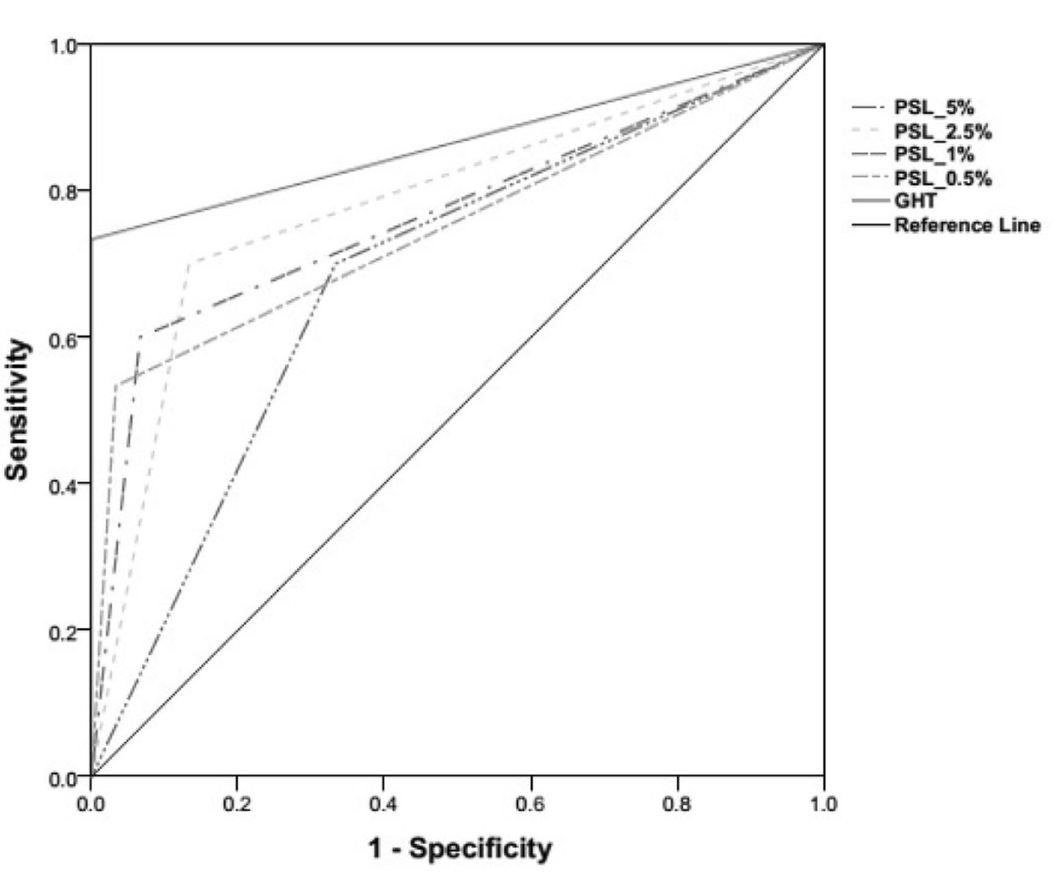
Figure 3. ROC curves plotted for the different levels of the normative PSLs of EMP; The PSL values were obtained from SRT estimated at the level of 5%, 2.5%, 1% and 0.5%.